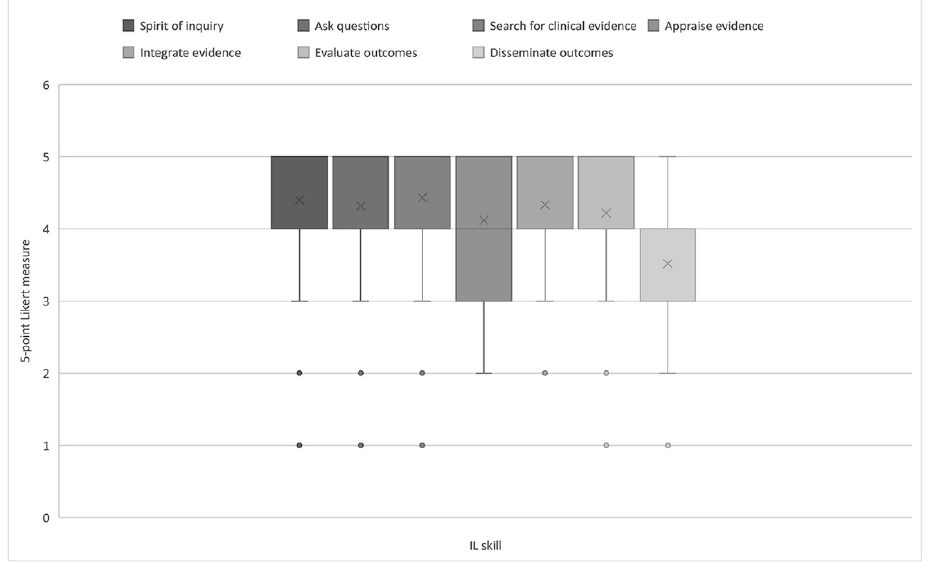
Figure 2 Nursing faculty ratings of the relevance of IL skills at the baccalaureate